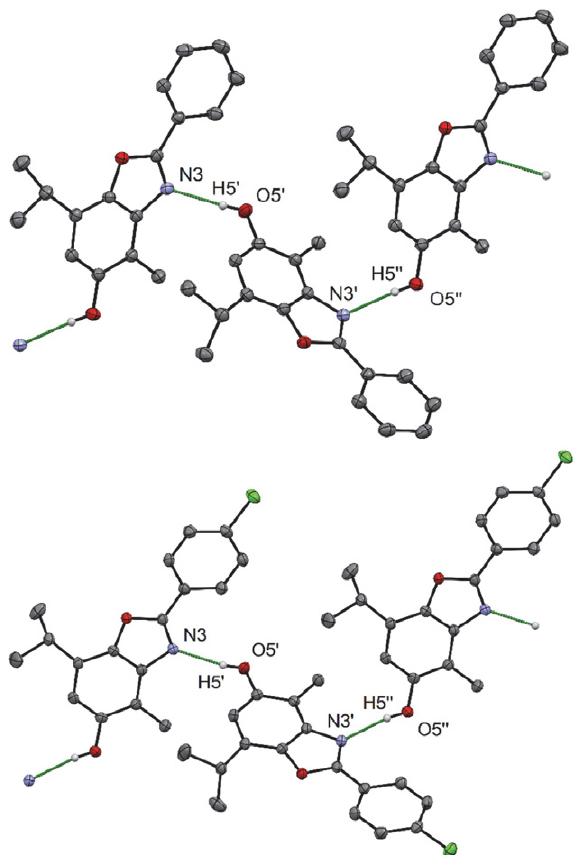
Figure 4. Hydrogen bond network in the crystal structures of com- pounds 1 (top) and 3 (bottom). The hydroxyl group in position 5 forms intermolecular hydrogen bonds (green) with the benzoxazole N3). N3 nitrogen (O5’–H5’ N3). Thermal ellipsoids are drawn at 50% probability level and non-relevant hydrogen atoms are ⋅⋅⋅ ⋅⋅⋅